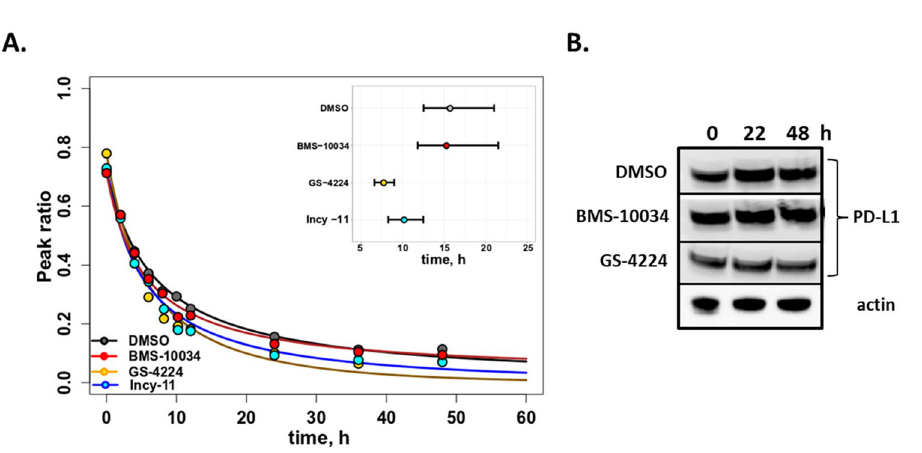
Figure 1. Chemical structures of compounds used in this study. GS-4224 27 and INCY-11 26 induce dimerization, while BMS-10034 is a non-dimerizing blocker 20 .